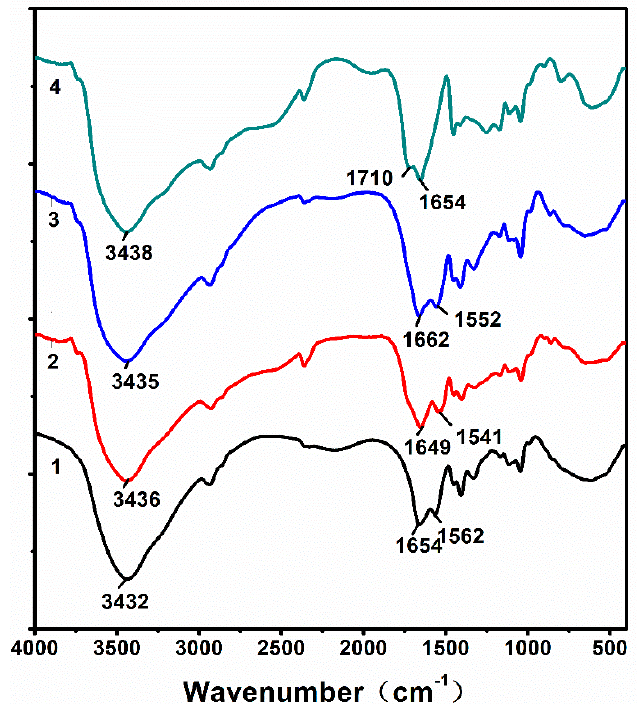
Figure 5. FTIR spectra of the ( 1 ) hydrogels, ( 2 ) hydrogels after adsorbing Pb 2+ , ( 3 ) hydrogels after adsorbing Cd 2+ , and ( 4 ) hydrogels after adsorbing Zn 2+ .